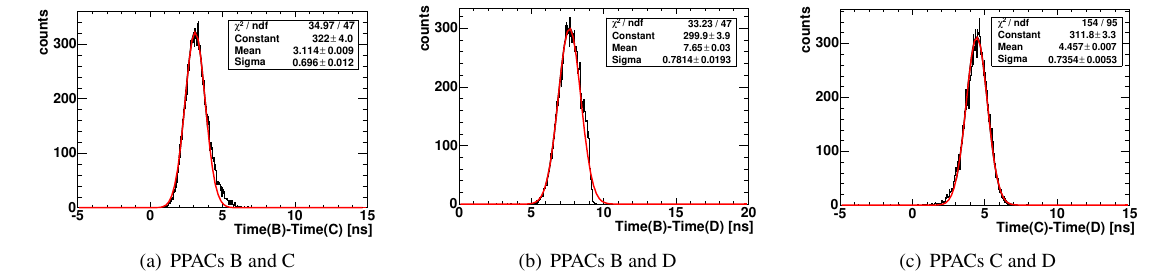
Figure 5. Measured time-di ↵ erence distributions (in black) and Gaussian fits (in red) for the case of light fission fragments from 252 Cf. Each plot represents a di ↵ erent pair of PPACs.